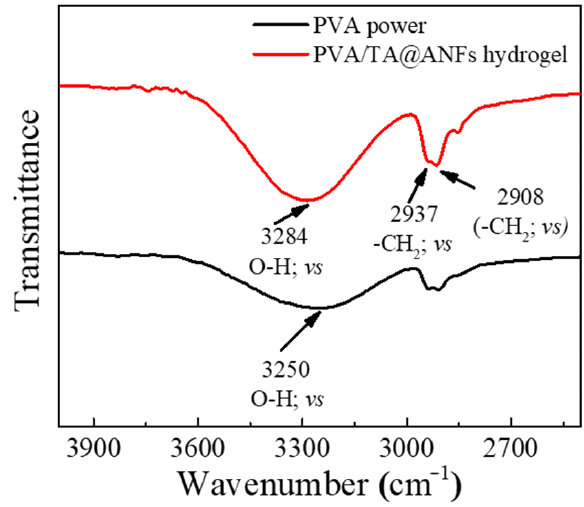
Figure 4. FTIR spectra of PVA powder (black line) and dry PVA/TA@ANFs’ hydrogel (red line).